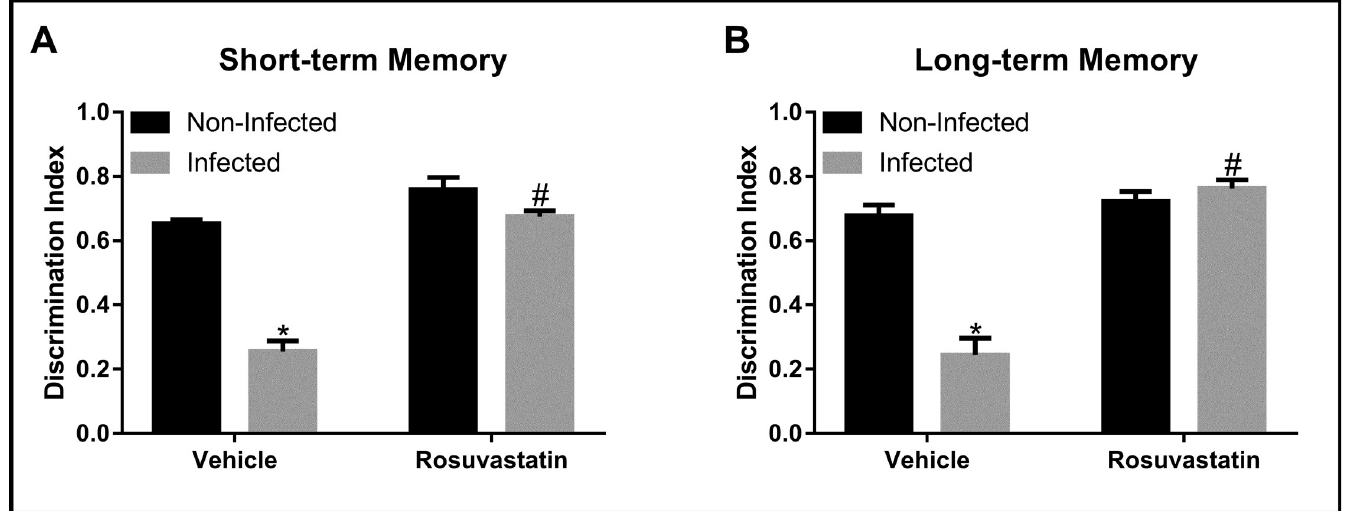
Fig 2. Cognitive non-emotional performance in the Novel Object Recognition (NOR) test in animals non-infected and infected with Toxoplasma gondii ME-49 strain and treated with rosuvastatin or vehicle. The bars represent the mean ± SEM. � P < 0.05 vs respective non-infected group, #P < 0.05 vs respective vehicle group. Two-way ANOVA followed by Bonferroni post-hoc test (n =